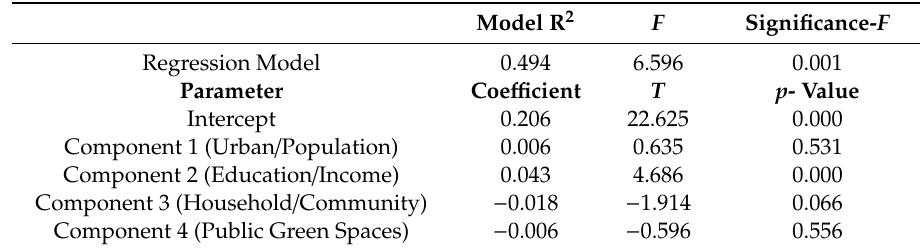
Table 5. Results of the multiple linear regression predicting excellent quality of QoUL life using PCA components.